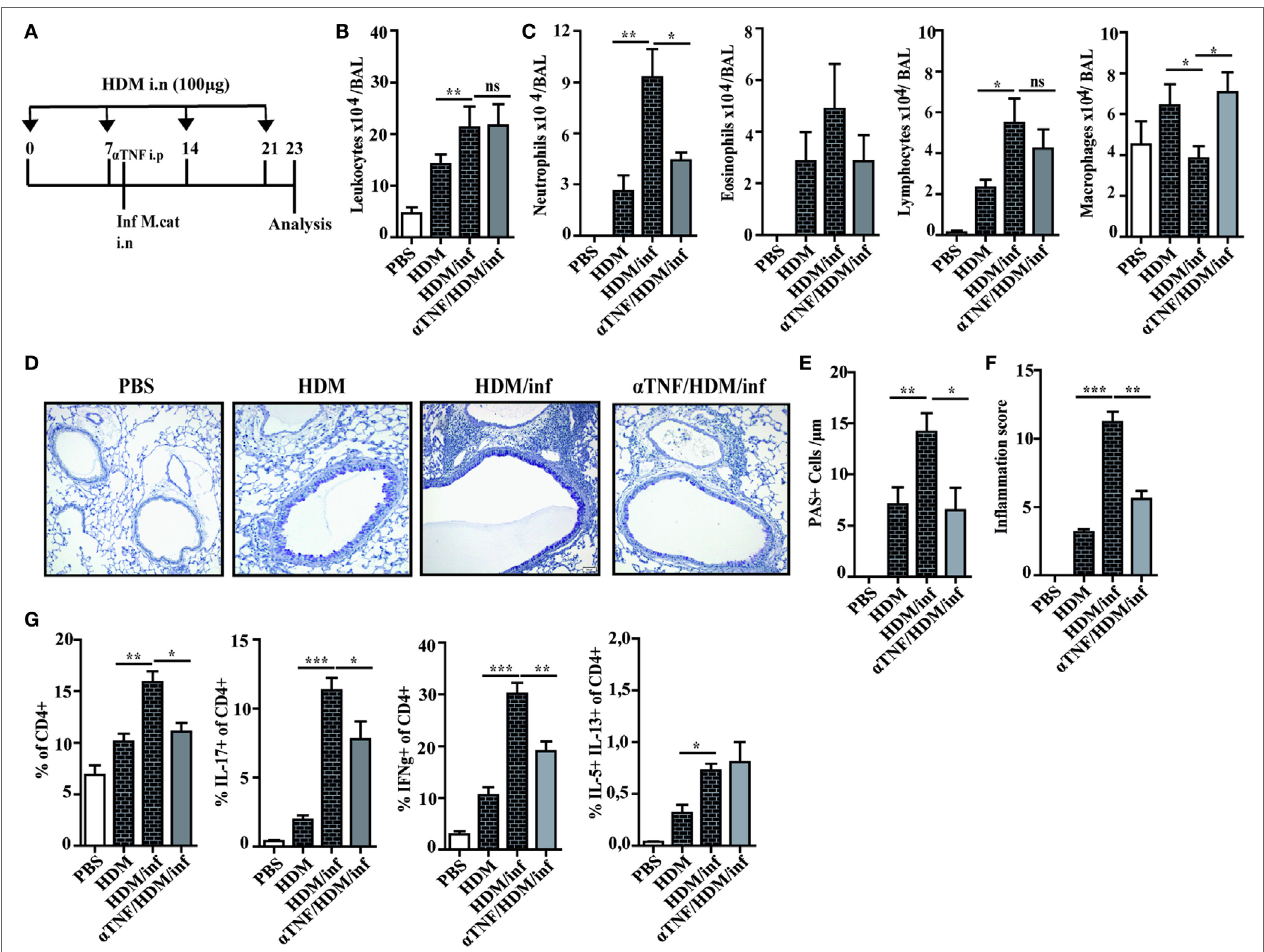
FigUre 6 | Anti TNF- α treatment alleviates M. catarrhalis -induced exacerbation of HDM AAI. C57BL/animals were infected (i.n.) with 2 × 10 8 CFU M. catarrhalis after the second HDM exposure. Mice were administered a single dose of 100 µg anti TNF- α or IgG1 control mAb 4 h prior to M. catarrhalis infection. BAL and lungs were analyzed at day 23. (a) Protocol (B) Total cell counts in BAL. (c) Differential cell counts. (D) Representative periodic acid Schiff-stained airways. (e) Goblet cell counts in lung tissues. (F) Inflammation score. (g) Intracellular staining of lung CD4 + T cells for IL-17A, IFN- γ , and IL-5/IL-13 positive cells. Data were from two independent experiments, n = 8 mice per group. *** P = 0.001, ** P = 0.01, and * P = 0.05 (one-way ANOVA). HDM, house dust mite; AAI, allergic airway inflammation; BAL, bronchoaleveolar lavage; ANOVA, analysis of